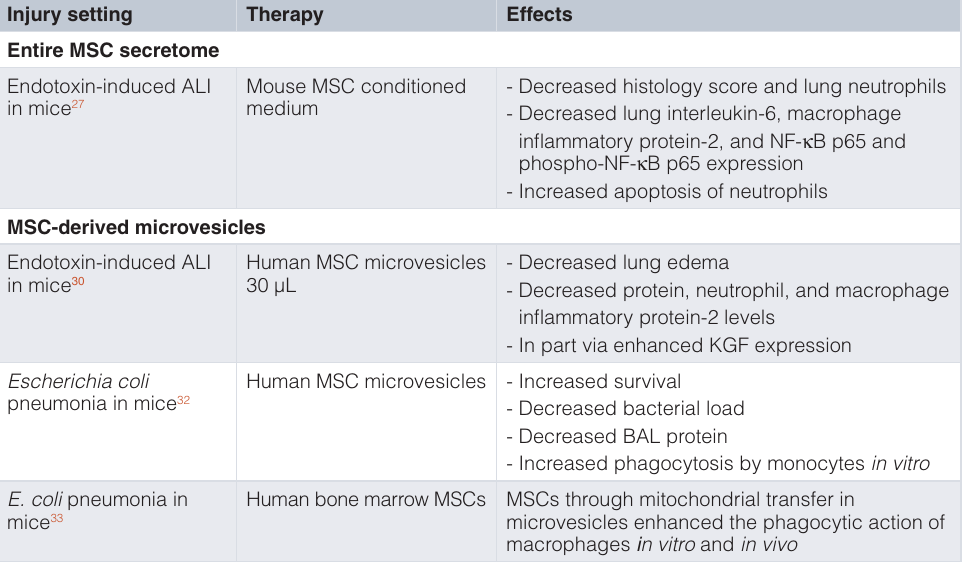
Table 2. The mesenchymal stromal/stem cell secretome: recent preclinical studies. Injury